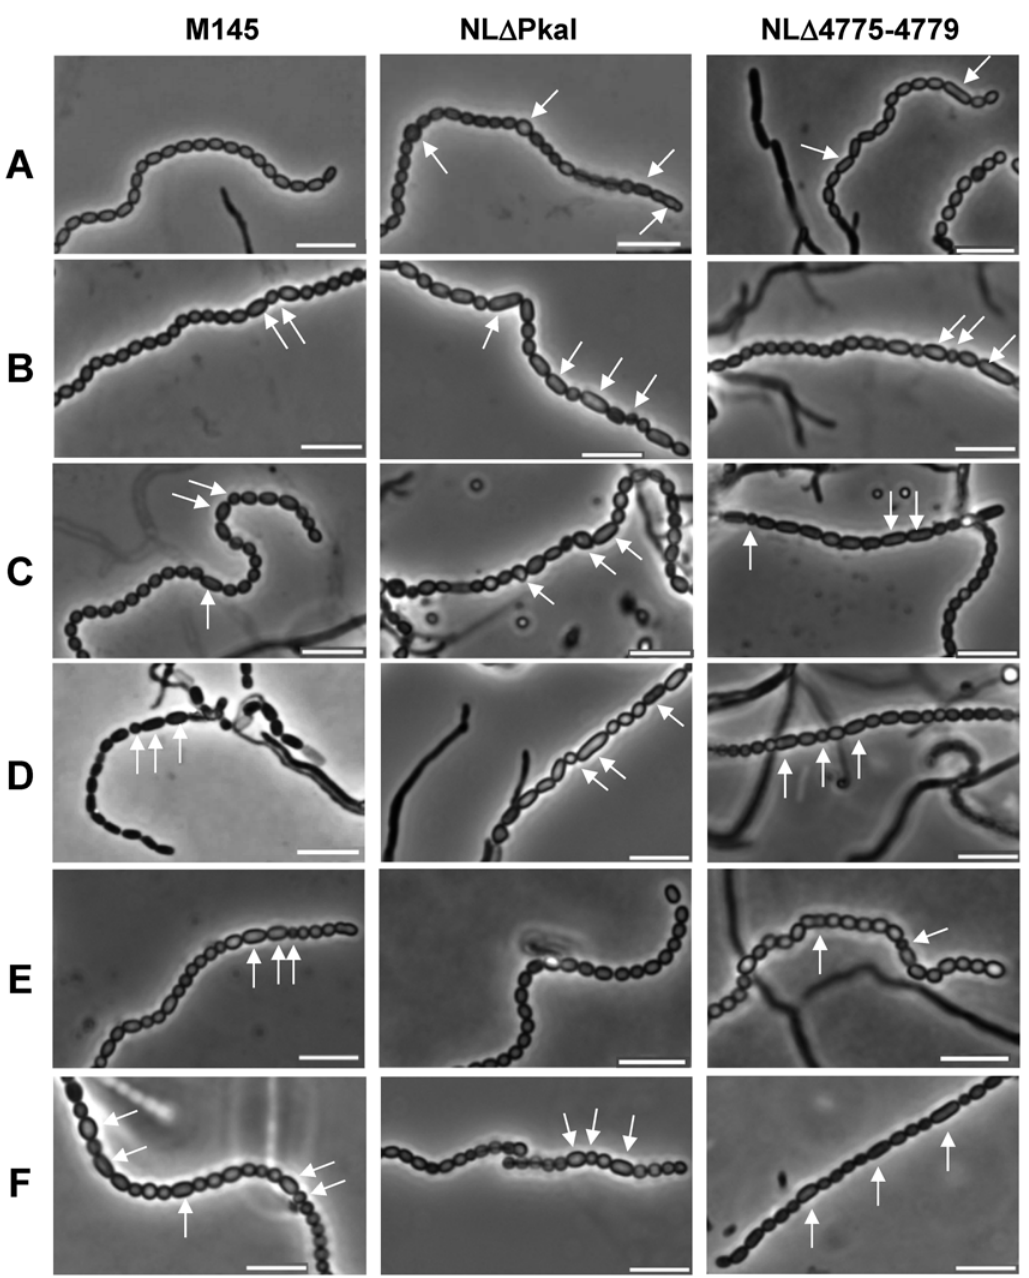
Fig 1. Effect of overbalancing phosphorylation activity on proper sporulation of S . coelicolor . Phase contrast microscopy of spore chains revealed the presence of aberrant spores (arrows) in eSTPK mutants NL Δ PkaI and NL Δ 4775 – 4779 (A). In contrast, spore chains of the parental M145 strain (A) and the complemented mutant NL Δ PkaI::pSET-pkaI (E) contain mainly regular ovoid spores. Not only deletion, but also expression of a second copy of any eSTPK gene of cluster SCO4775-4779 causes a similar sporulation defect (B-F, white arrows) in S . coelicolor M145, NL Δ PkaI, or NL Δ 4775 – 4779. None of the eSTPK genes is able to complement aberrant sporulation of the five-fold mutant NL Δ 4775 – 4779. A, no plasmid integrated; B, :: pSET152-pkaH; C, :: pSET152-SCO4776; D, :: pSET152-pkaD; E, :: pSET152-pkaI; F, :: pSET152-pkaJ. Bar = 5 μ m.